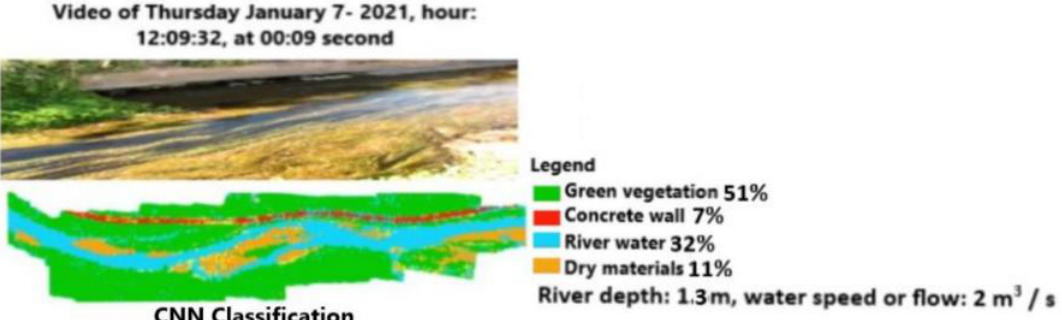
Figure 16. Video frame classification based on a CNN at 12:09:32.